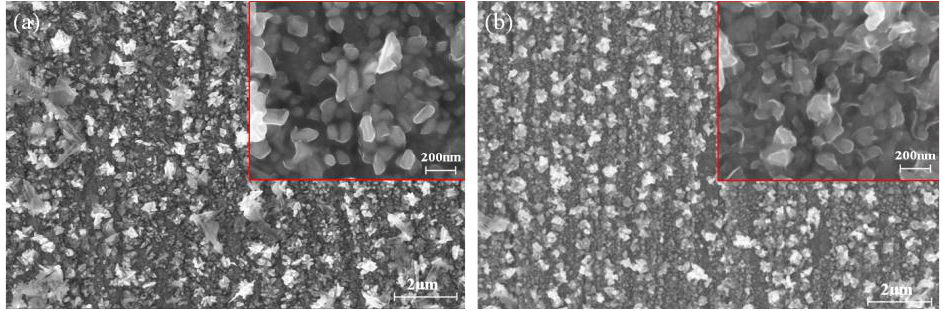
Figure 15. SEM images of bismuth electrodeposition products obtained under different deposition potentials: ( a ) − 0.47 V, ( b ) − 0.55 V (T = 323 K, c(BiCl 3 ) = 0.10 M).